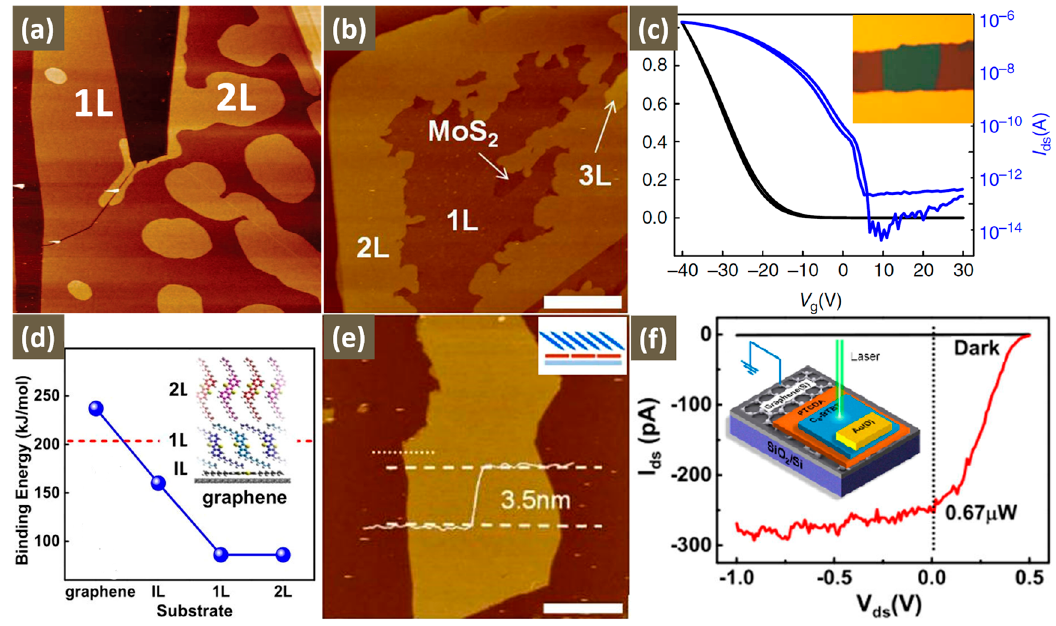
Figure 6. C 8 -BTBT on layered substrates. AFM image of C 8 -BTBT on G ( a ) and MoS 2 ( b ). ( c ) Transfer characteristic of 1L C 8 -BTBT/ h -BN based planar OFET at room temperature. Black and blue lines are drawn in linear and log scales, respectively. Inset shows the optical microscopy image of the device. ( d ) Blue dots: calculated binding energies of a single C 8 -BTBT molecule on G, IL/G, 1L/IL/G, and 2L/1L/IL/G. Red dash line: C 8 -BTBT − C 8 -BTBT interaction. Inset shows the molecular structure of C 8 -BTBT and molecular packing of different C 8 -BTBT layers on G. ( e ) AFM images of SLOMBE of bilayer C 8 -BTBT on PTCDA. ( f ) Output characteristics of the p-n junction (>15 nm) under the dark conditions (black) and under the 0.67 µ W laser illumination. Inset shows schematic layout of the device. Panel a, c reprinted with permission from [56], copyright 2014, Nature Publishing Group. Panel b reprinted from [57], with the permission of AIP Publishing. Panel d, e, f adapted with permission from [67], copyright 2016 American Chemical Society.